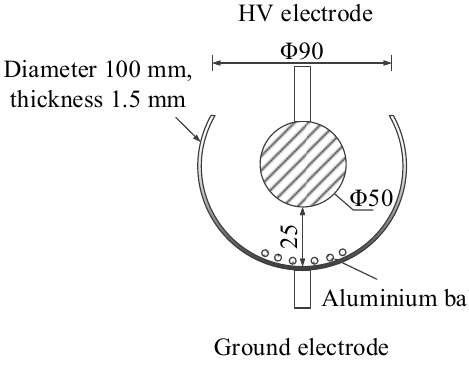
Figure 4. Insulation defect model (Unit: mm).